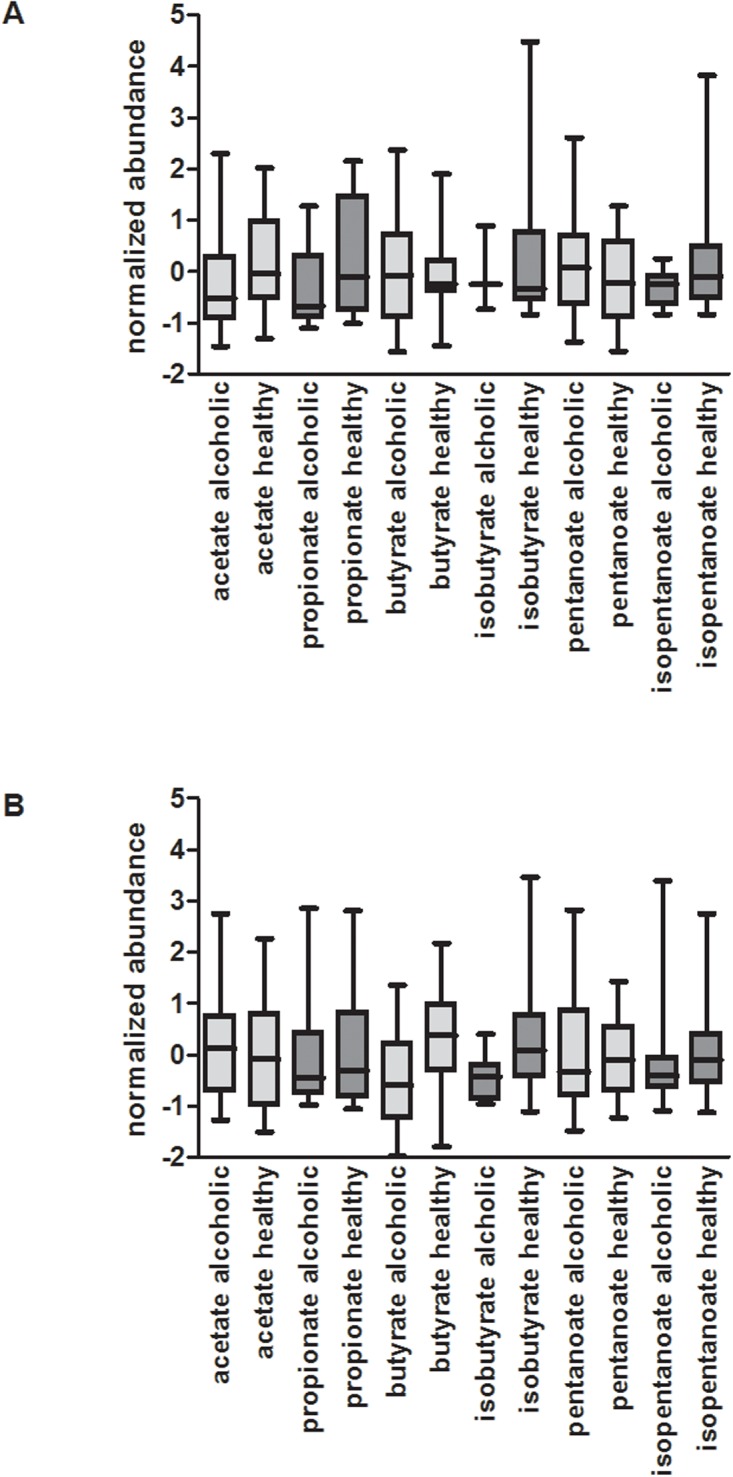
Comparison of SCFA abundance among the cohorts.Box plots are presented, depicted as described in Fig.8. A) Among the endoscopy collected samples, while most of the SCFAs are comparable in abundance within the healthy and alcoholic cohorts, propanoic acid demonstrates a statistically significant reduction in median abundance in the alcoholic cohort relative to the healthy cohort (p = 0.03, fold change = 2.32). B) In the home collected samples, butyrate has a 1.6 fold reduction in median abundance, while the remaining SCFAs are very similar between the healthy and alcoholic fecal samples. See text for further discussion.